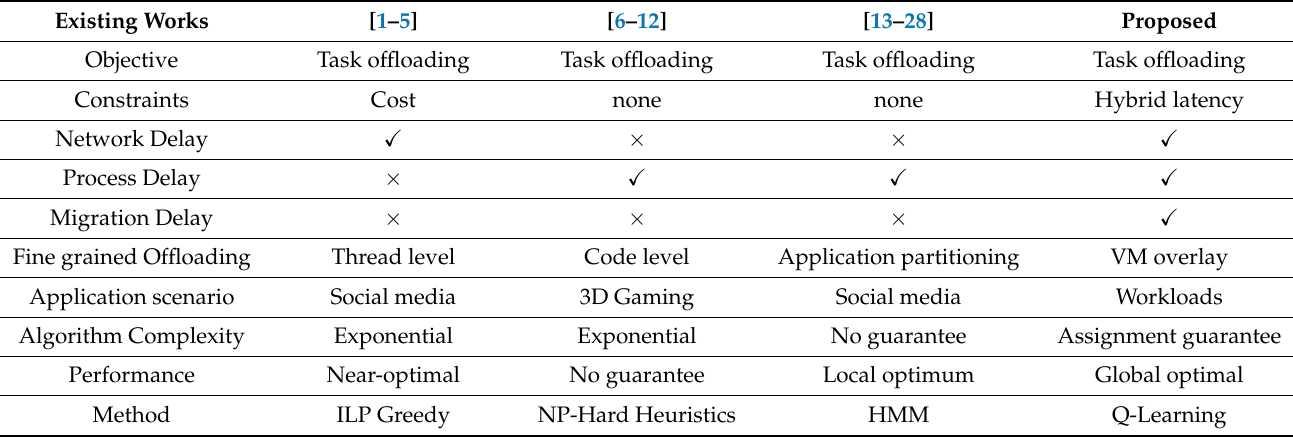
Table 1. Comparison among existing works and the proposed